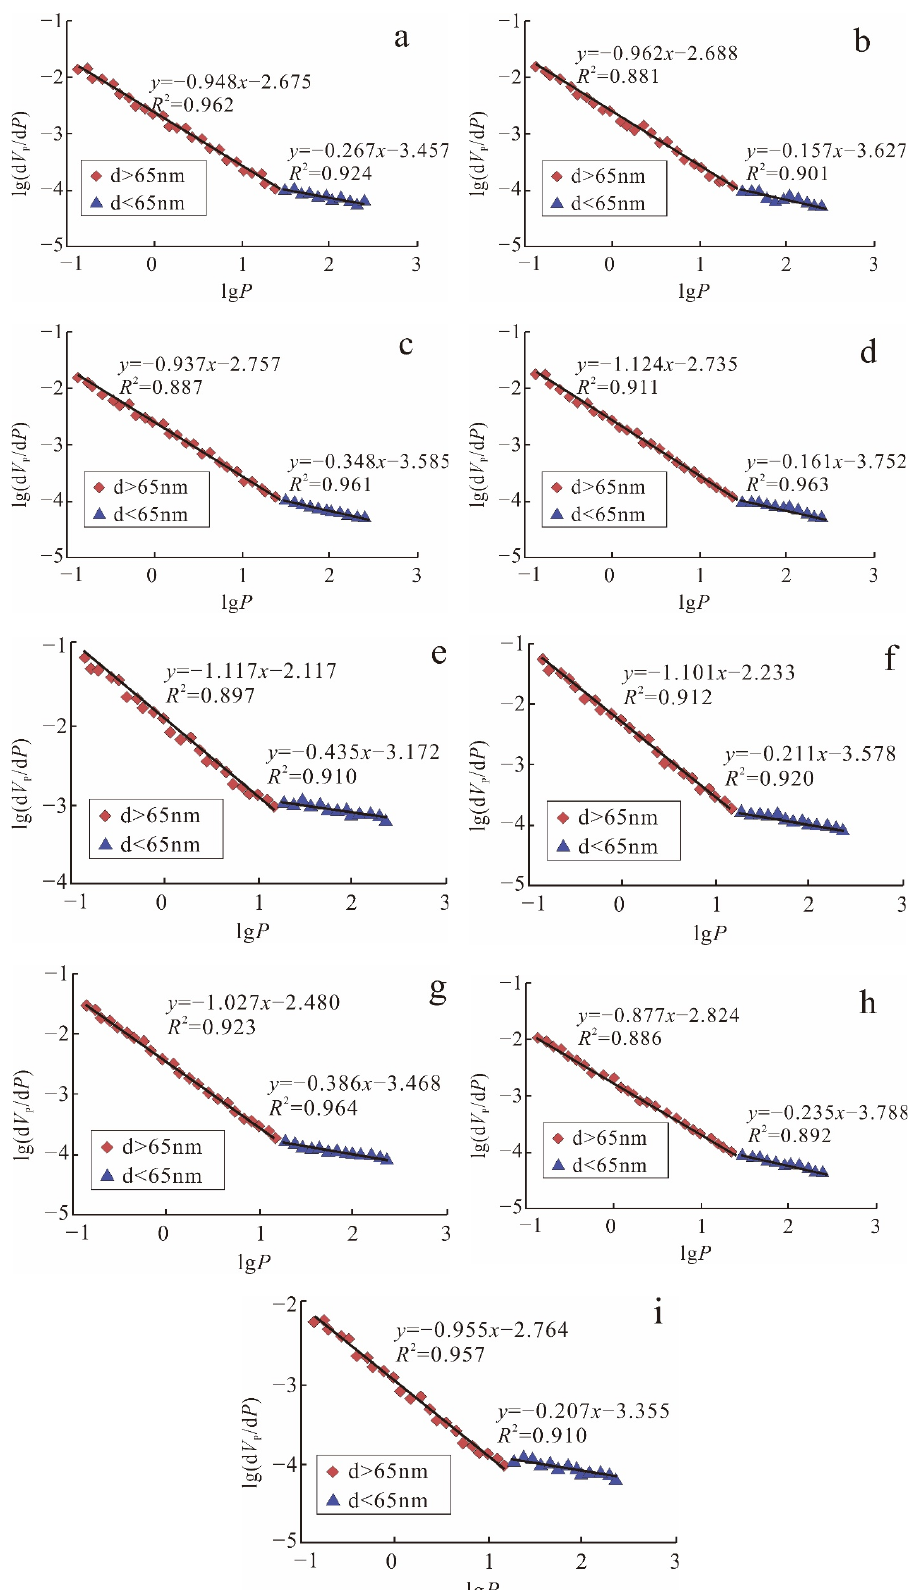
Figure 2. Plots of lg( dV P / dP ) as a function of lg P for selected samples ( a ): Sample M 1 ; ( b ): Sample M 2 ; ( c ): Sample S 1 ; ( d ): Sample F 1 ; ( e ): Sample W 1 ; ( f ): Sample W 2 ; ( g ): Sample W 3 ; ( h ): Sample G 1 ; ( i ): Sample H 1 ). Table 2 lists the fractal dimension, correlation coefficient, and pore size ratio of some coal samples with different pore sizes. According to Equation (2), the comprehensive frac ‐ tal dimension ( D t ) of each coal sample is obtained as a weighted average. The results in Table 2 show that the percolation fractal dimensions ( D p ) of coal sam ‐ ples are between 2.88 and 3.12, the diffusion fractal dimensions ( D d ) are between 3.57 and 3.84, and the comprehensive fractal dimensions ( D t ) are between 3.05 and 3.63. The D d of all coal samples are all larger than D p , which indicates that the random distribution and complexity of diffusion pores in coal are stronger than that of the percolation pores. Table 2. Calculation results of fractal dimension of some coal samples. Sample Nos.